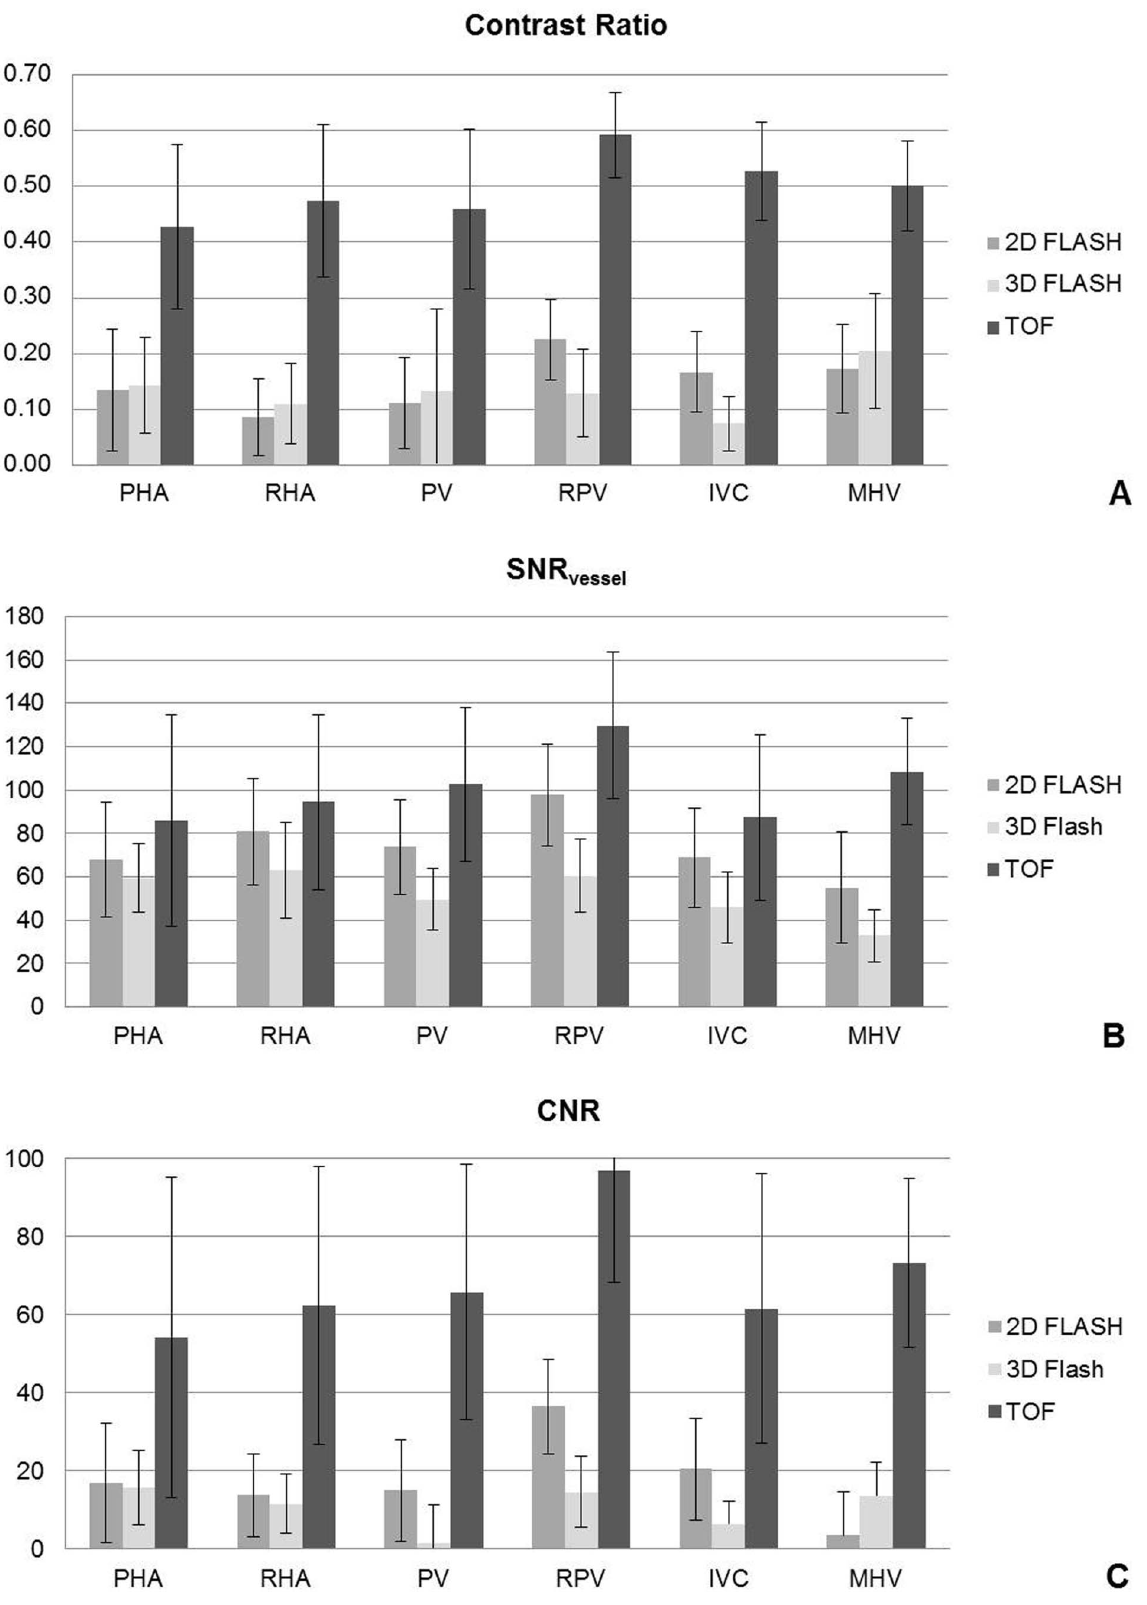
Figure 3. Quantitative analysis (A: Contrast ratios, B: SNR vessel , C: CNR) for all analyzed liver vessel segments in all three sequences.